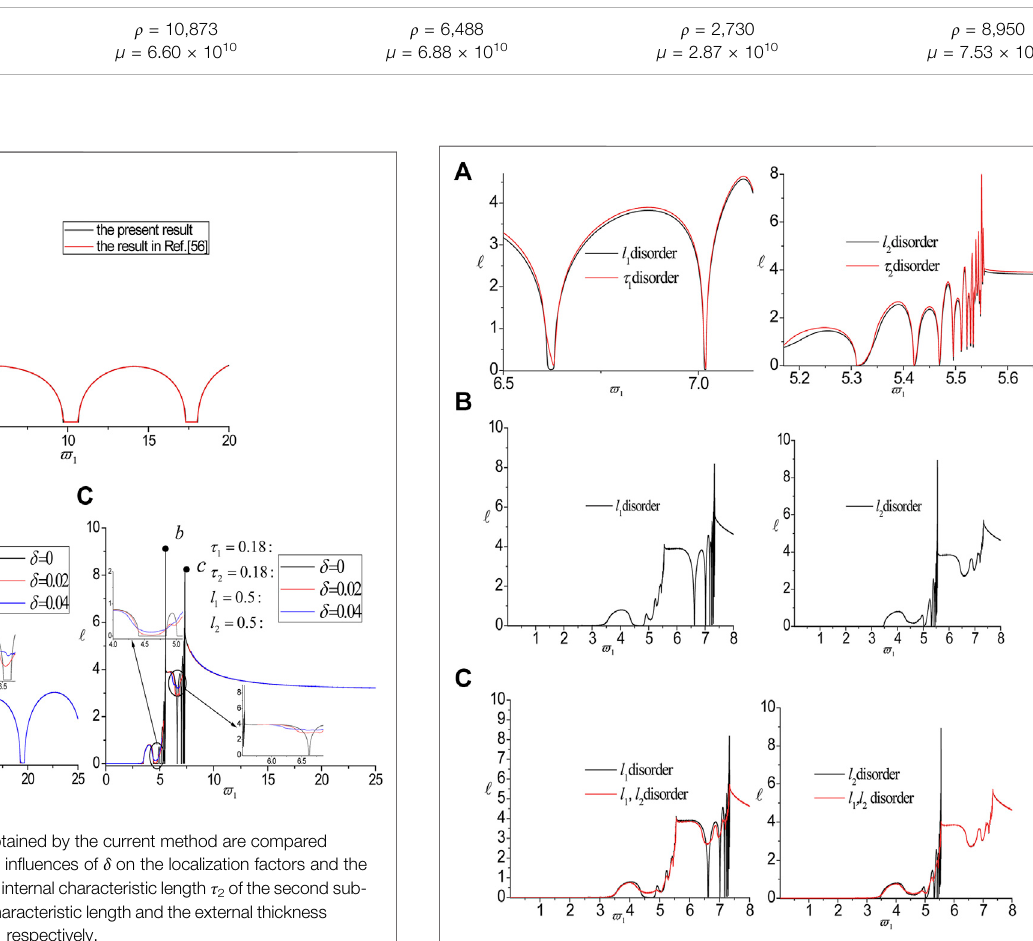
FIGURE 3 | The in fl uences of disorder on the localization factors for δ = 0.08.Theinternalcharacteristiclengthsandtheexternalthicknessofthesame sub-layer (A) , the disorder of different sub-layers (B) and the number of disorder (C) ,